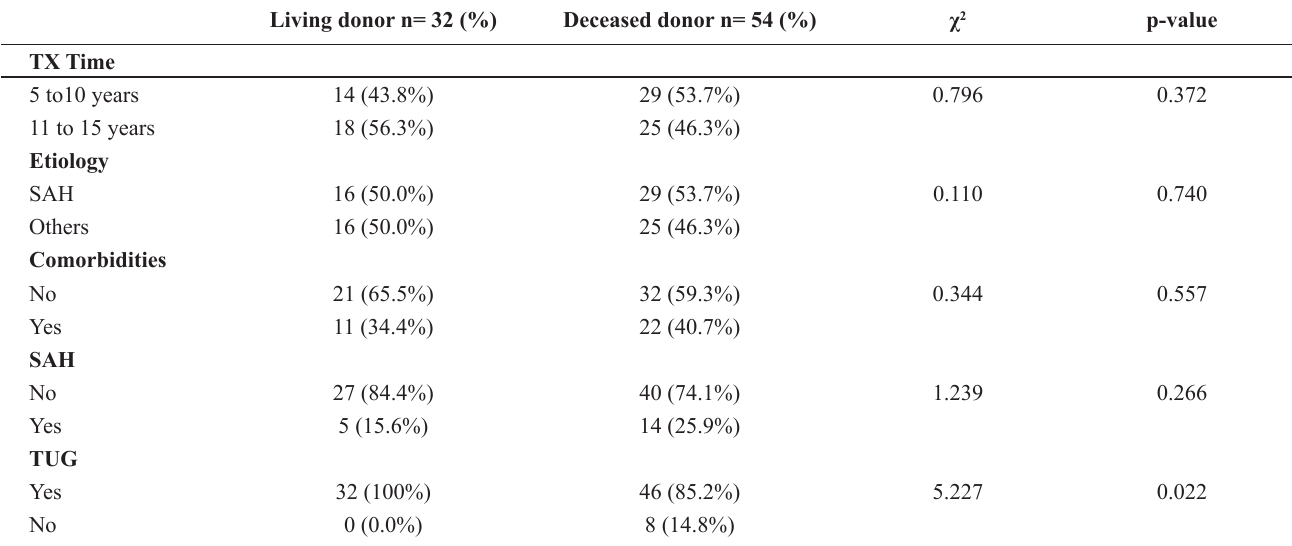
Table 2. Characteristics of individuals related to the type of kidney transplant (living donor and deceased donor). Living donor n= 32 (%) Deceased donor n= 54